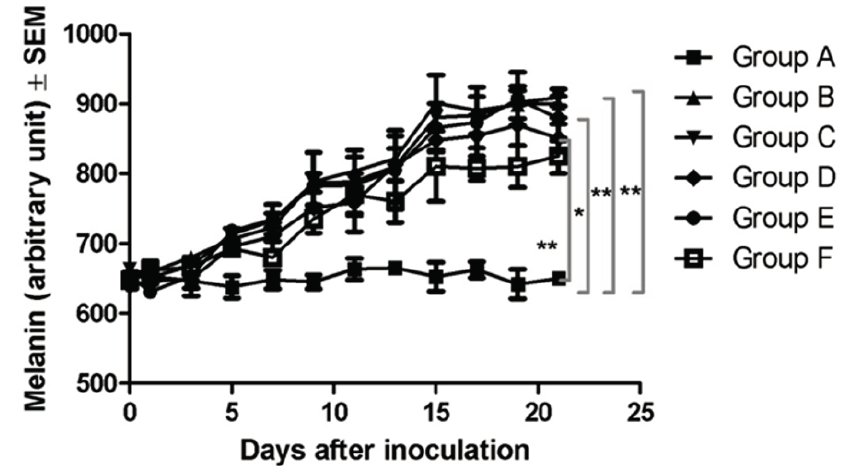
Figure 4. Melanin amounts (in arbitrary units (A.U.) as determined by the manufactured device) in the different experimental groups on day 21 of the experiment. * p < 0.05, ** p <